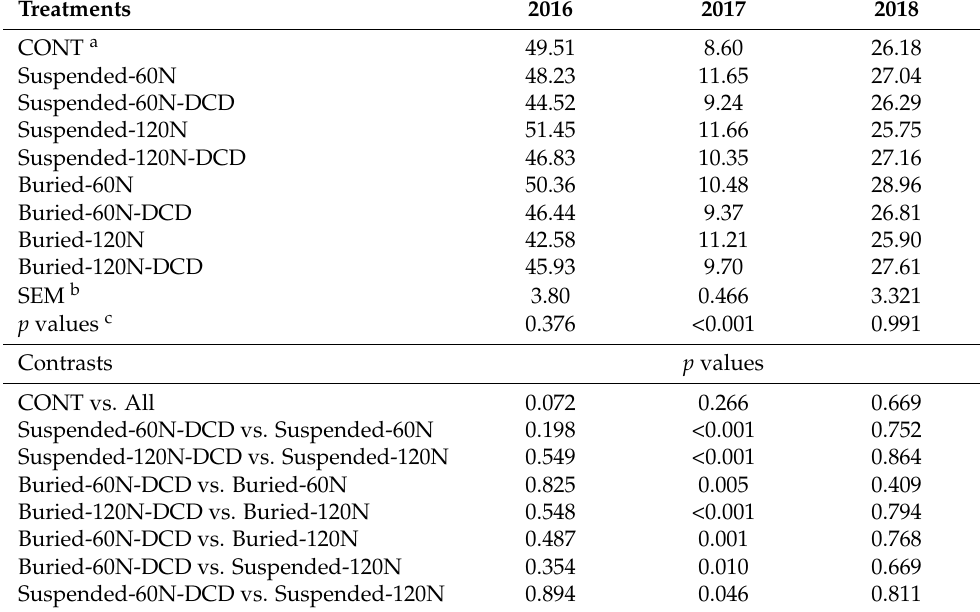
Table 2. Total berry yield (Mg ha − 1 ) with varying combinations of nitrogen rates (60 and 120 kg N ha − 1 ), fertigation methods (suspended and buried) and inhibitor (2-chloro-6-(trichloromethyl)-pyridine (Nitra-pyrin), di-cycandiamide (DCD)) to blueberry during three production years (2016–2018).